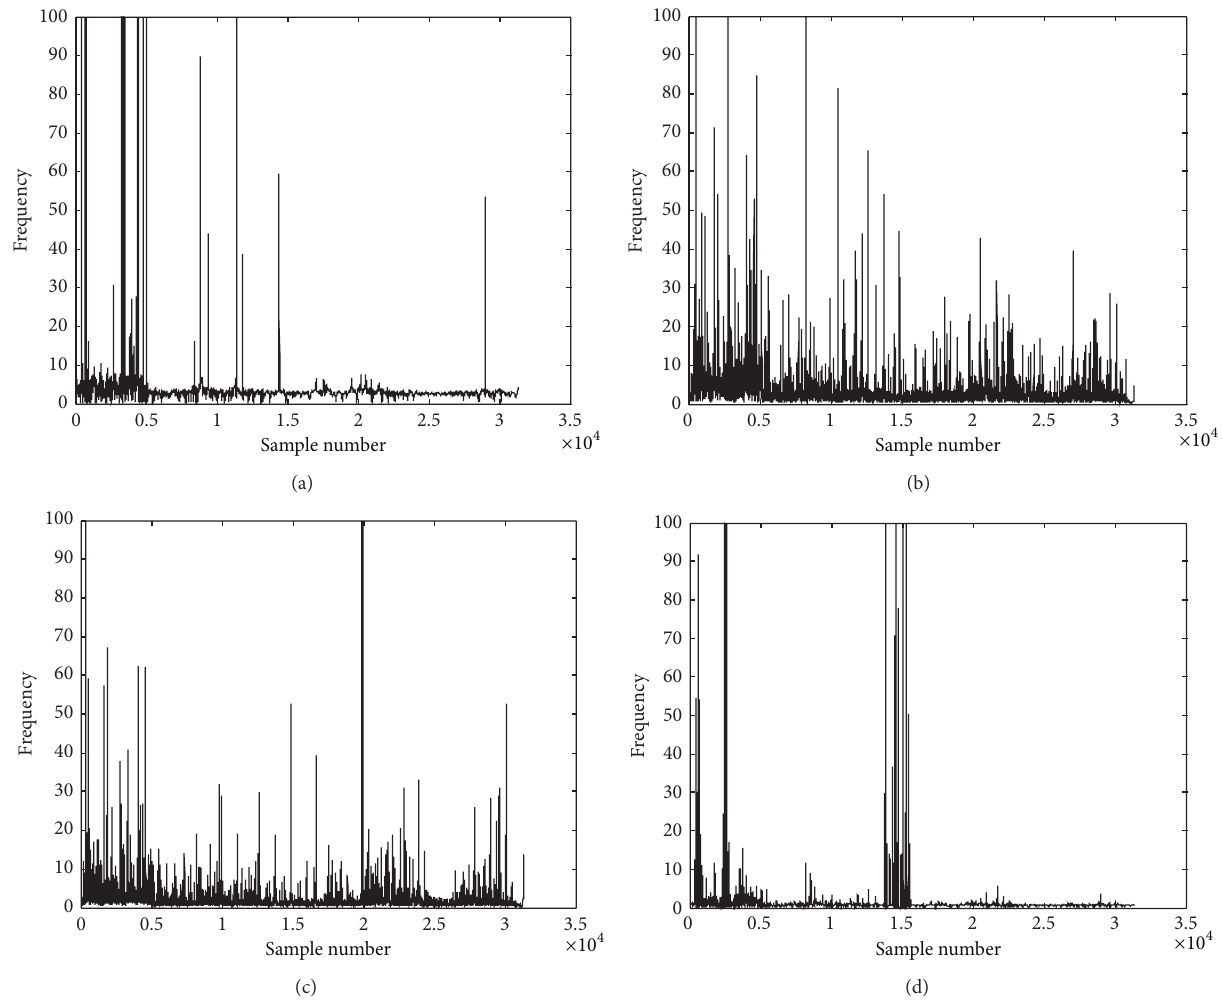
Figure 5: Extracted time-frequencies of acceleration response. (a) HHT, (b) TEO, (c) HEO, and (d) DQ.